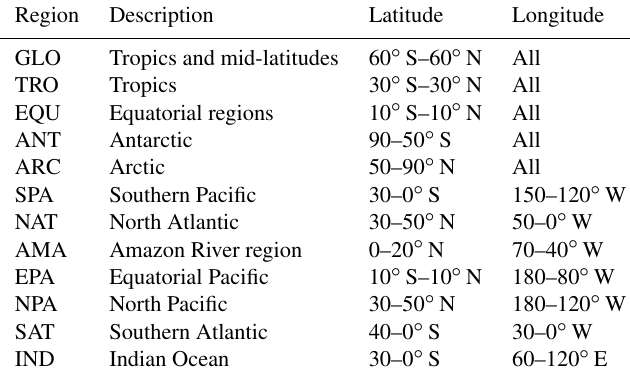
Table 2. Ocean regions used in the statistics with respect to Argo SSS.